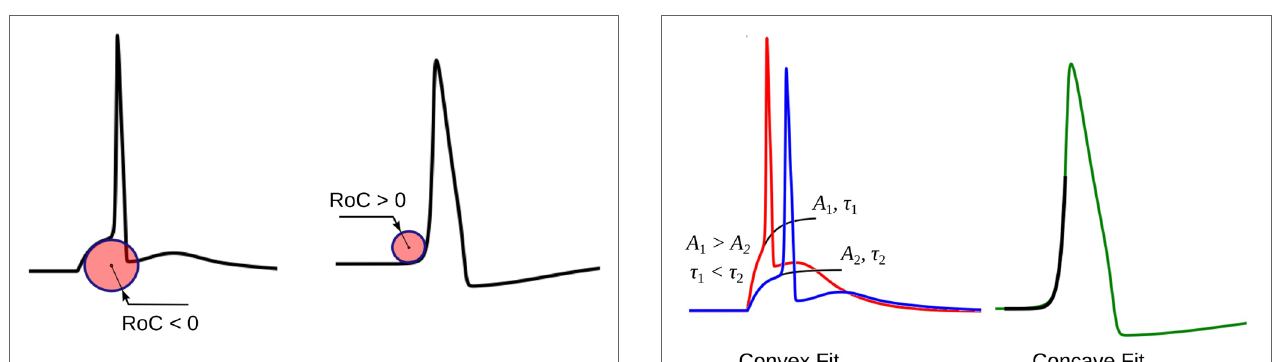
FIgURe 5 | The physical significance of the radius of curvature (RoC). The RoC values measured at convex foot is negative and that in concave foot is positive. These signs are flipped to match the convention followed in other